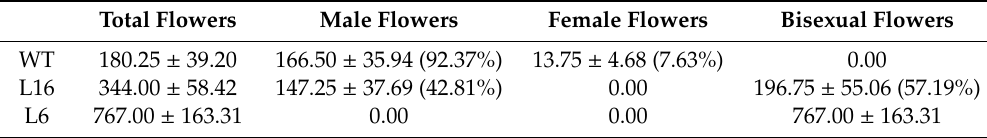
Table 1. Numbers of male, female, and bisexual flowers per inflorescence in the WT plants and the transgenic lines L16 and